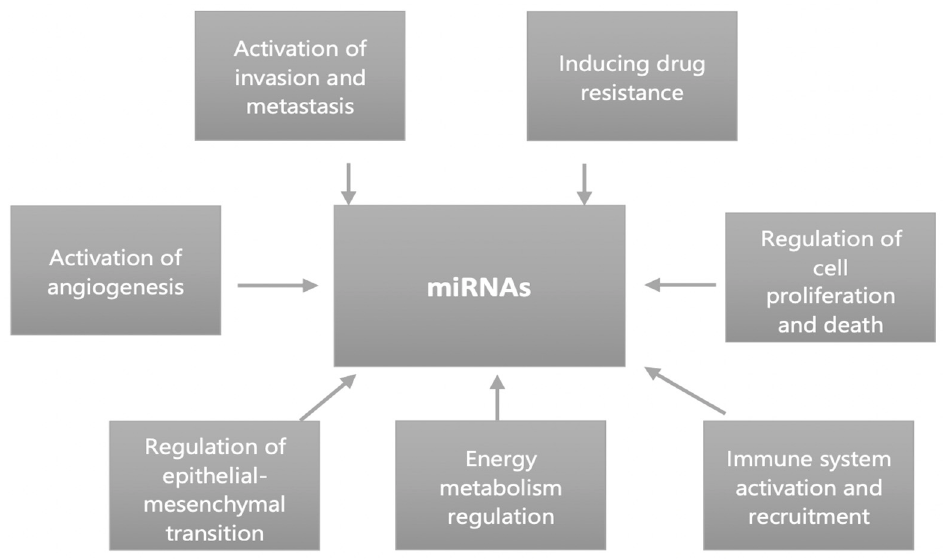
Figure 1. Cellular mechanisms regulated by miRNAs.